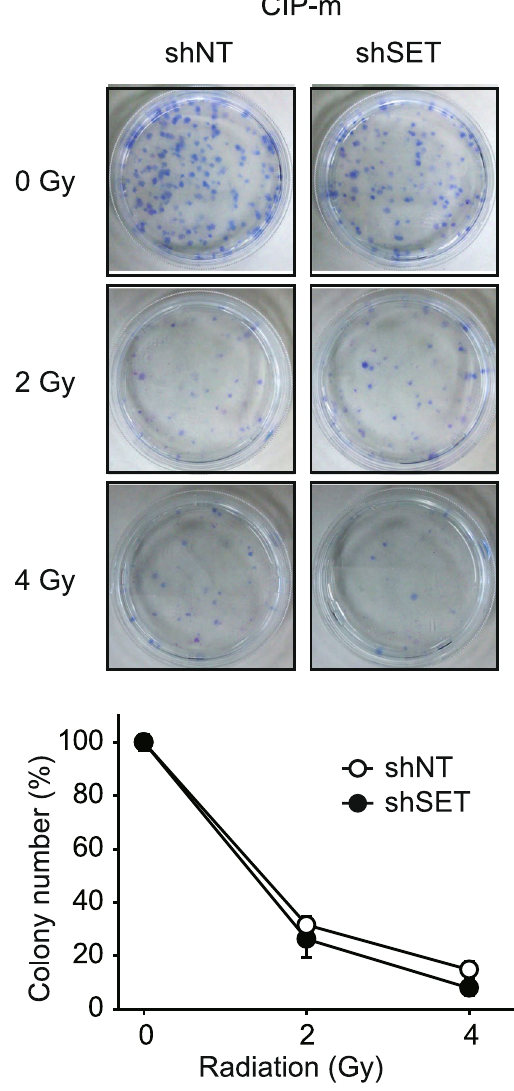
Figure 7. SET knockdown does not affect the sensitivity for radiation therapy. Colony formation ability of CIP-m cells expressing shNT or shSET after exposure to X-ray radiation (2 and 4 Gy) was analyzed. Representative pictures and quantitative data normalized with 0 Gy as 100% were shown. Quantitative data from 3 independent experiments performed duplicate are